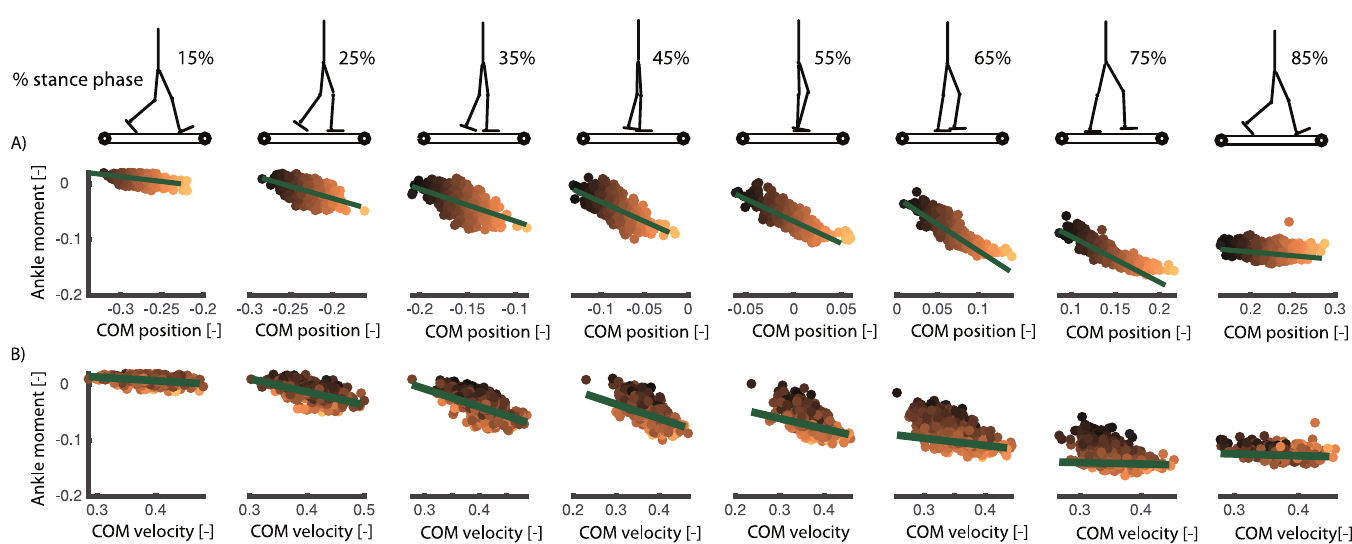
Fig 7. Continuous treadmill perturbations walking (data from [27]). Representative example of the relation between ankle joint moment and COM position and velocity in walking with continuous changes in the speed of both belts. The different columns in the plots are time bins equally spaced during the stance phase of walking. The colored dots represent the different strides of this subjects (with the color tint representing the deviation in COM position), the slopes of the green green lines are the resulting position and velocity gains from the least squares regressions. The change in slope of the green lines show the phase-dependency of the linear regression between COM position and velocity and the ankle moment during perturbed walking. Note that we show the total joint moment and muscle activity and not only the deviation from the average unperturbed data in each gait phase. This to indicate if a specific muscle is active, or the magnitude of a joint moment, in the gait phase during unperturbed walking.